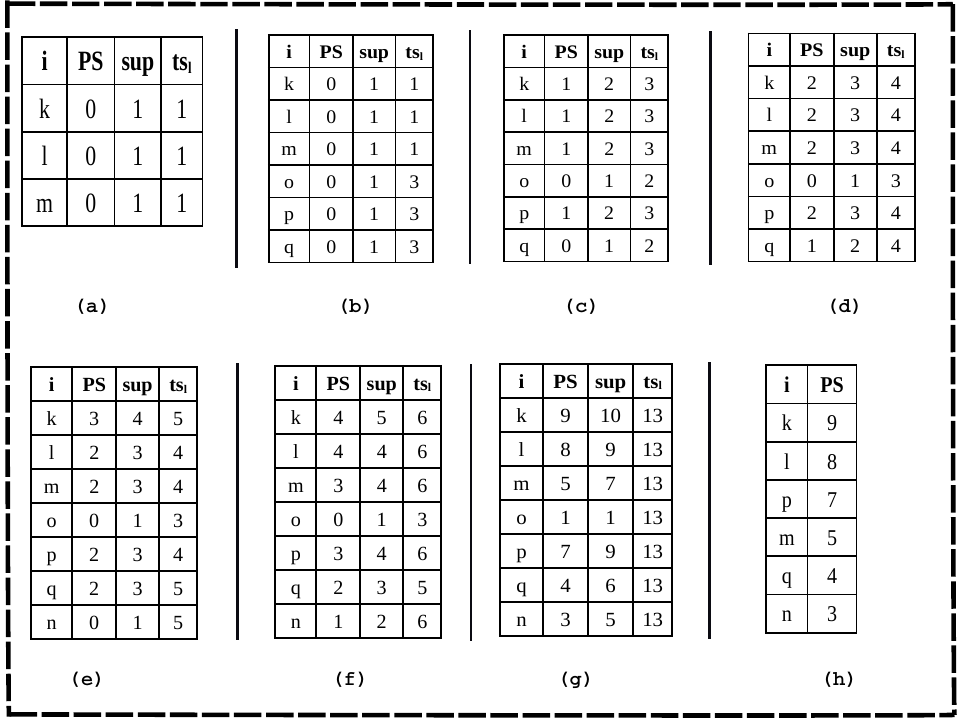
Figure 2. Construction of the 3P-List: ( a ) the content of the list after reading the first transaction; ( b ) the content of the list after reading the second transaction; ( c ) the content of the list after reading the third transaction; ( d ) the content of the list after reading the fourth transaction; ( e ) the content of the list after reading the fifth transaction; ( f ) the content of the list after reading the sixth transaction; ( g ) the content of the list after reading the entire database; ( h ) the final 3P-list containing the sorted list of